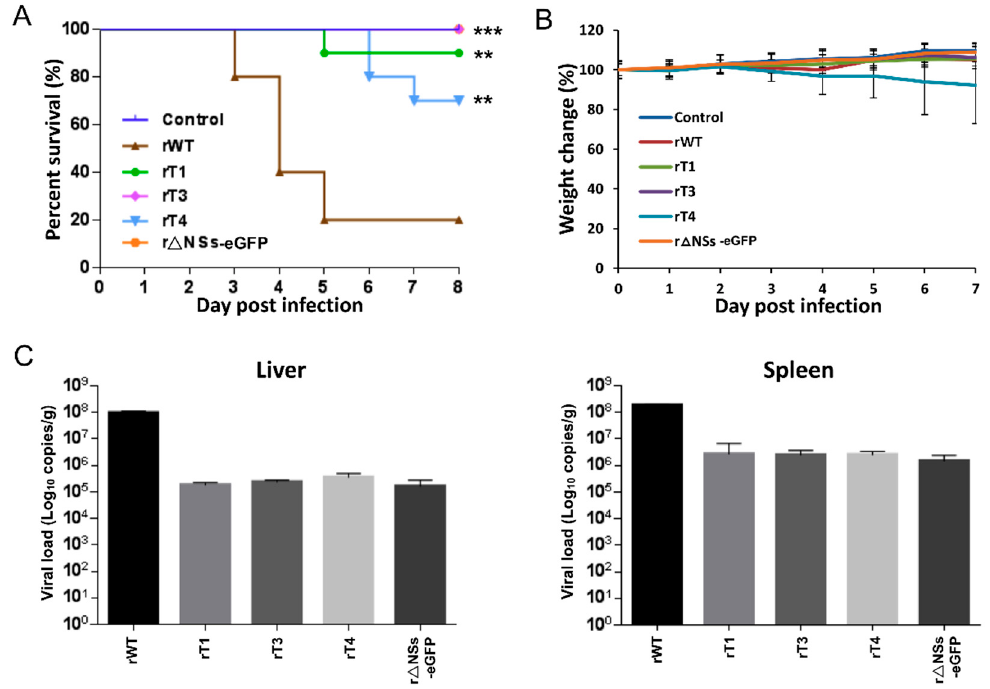
Figure 5. Analysis of the in vivo virulence of NSs mutant viruses. Six-week-old BALB/c mice were intraperitoneally inoculated with 5 PFU of rWT, rT1, rT3, rT4 or r △ NSs-eGFP, or inoculated with PBS as a control. The mice in each group ( n = 10) were observed for 7 days on a daily basis after infection. The mice survival rates ( A ) and body weights ( B ) were evaluated. Error bars represent standard deviation. Comparison of survival curves between mutants and rWT was analyzed by Log-rank (Mantel–Cox) testing. *** p < 0.001, ** p < 0.01. The p values were calculated based on comparison with the rWT. ( C ) Liver and spleen samples were harvested from infected mice 5 days post infection. RNA was extracted from tissue homogenates using TRIzol Reagent. RNA viral